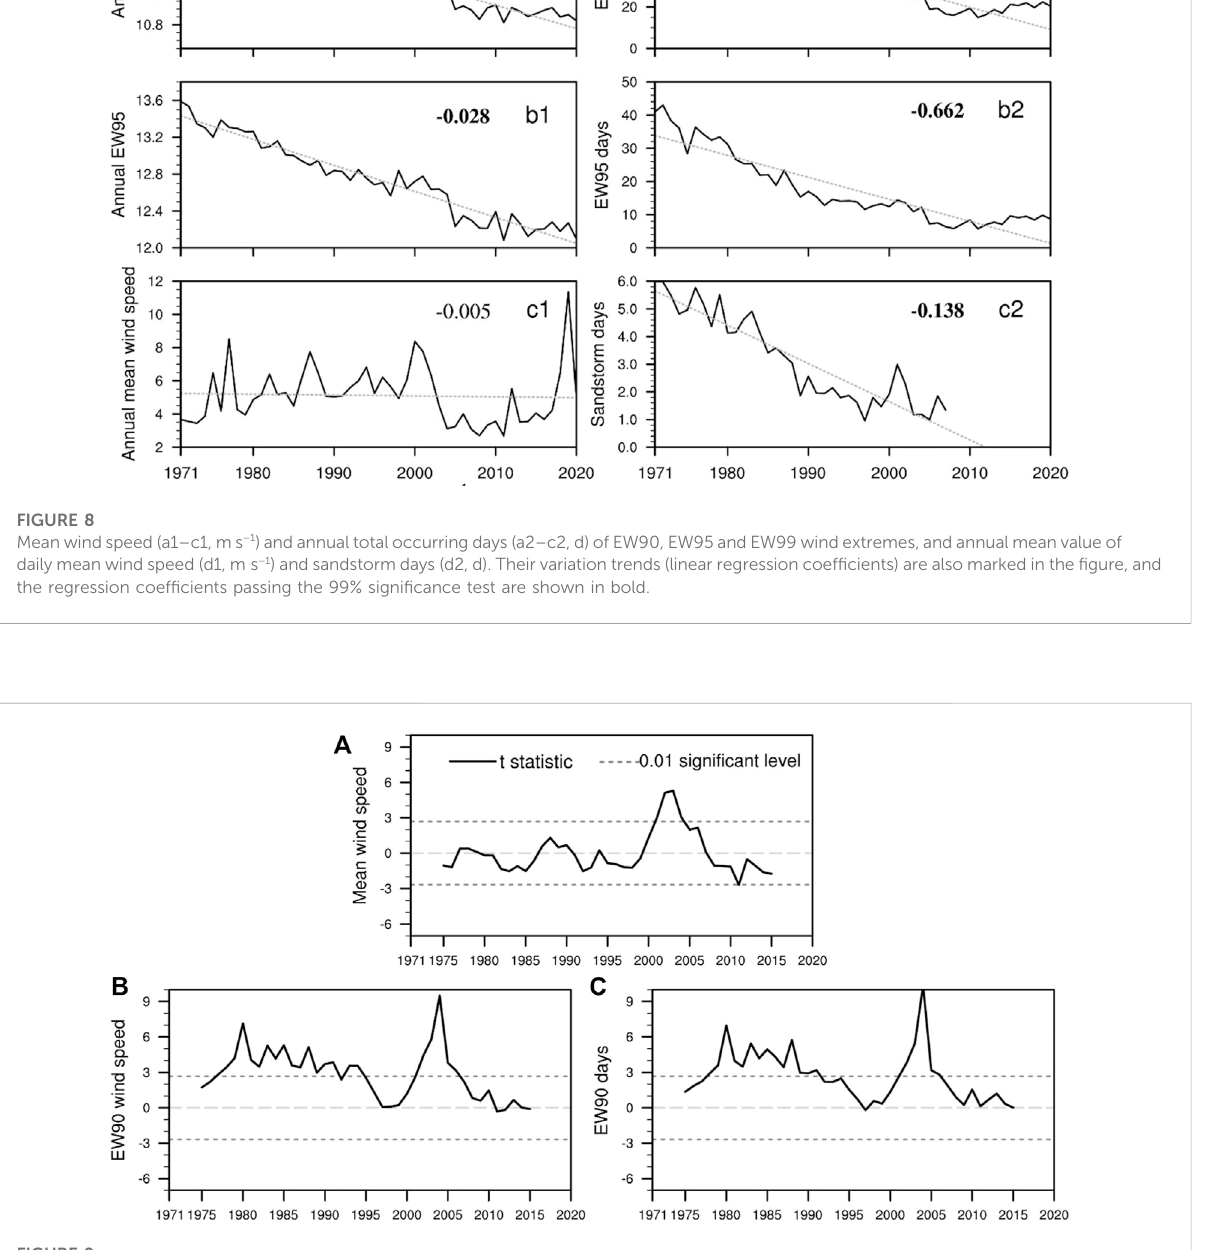
FIGURE 9 The results of moving-T test for the annual mean wind speed (A) , EW90 extreme-wind speed (B) and extreme-wind days (C)